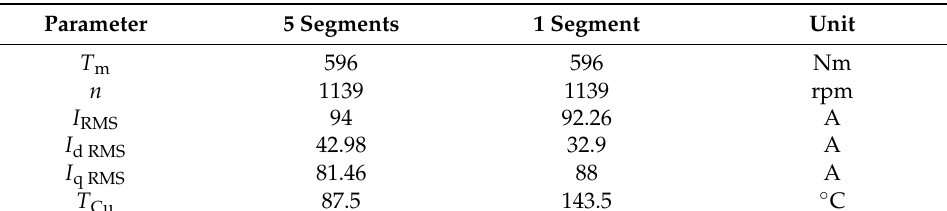
Table 4. Motor operating parameters in the 847th second of the Artemis Urban drive cycle, with magnet segmentation and without magnet segmentation.